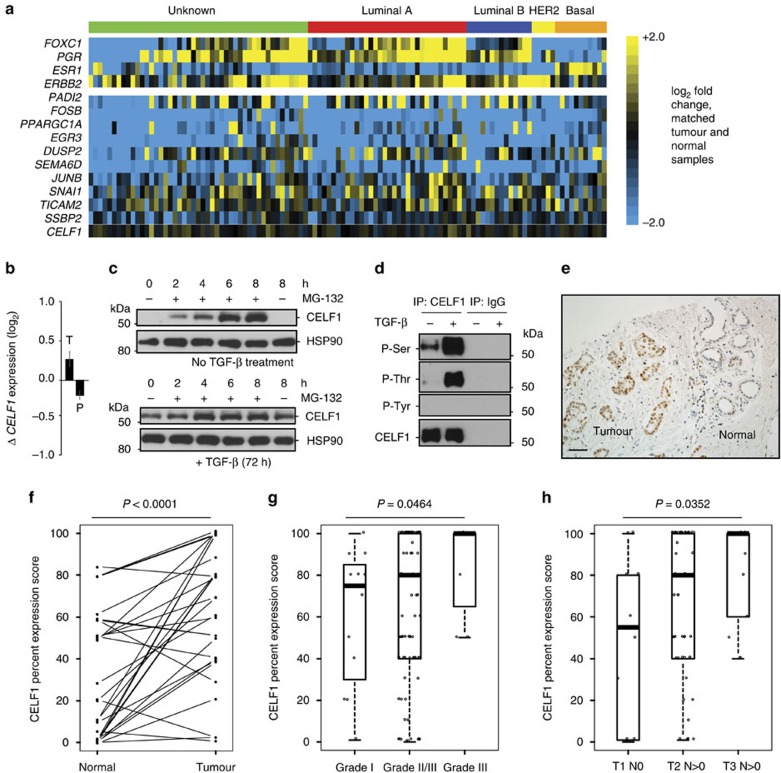
Enhanced CELF1 expression in human breast cancer correlates with increased metastasis.(a) Heat map depicting log2-fold difference in mRNA expression of indicated genes between tumour-normal matched pairs for 111 TCGA patients. Topmost coloured bar indicates PAM50 assignments. Columns are ordered by PAM50 subtype. Top: heat map shows exemplary set of genes correlated with subtype, and bottom: heat map depicts genes translationally regulated by CELF1 during EMT and CELF1. For each heat map, rows are ordered by decreasing variance from top to bottom. Columns are ordered by PAM50 assignment and within PAM50 assignment by increasing mean log2-fold change of genes from left to right. (b) qRT-PCR-based determination of change in steady-state and polyribosomal-bound CELF1 mRNA using total (T) and polyribosomal (P) mRNA obtained from untreated and TGF-β-treated MCF10A cells. Data are represented as mean±s.e.m. All panels are representative of a minimum of three experimental replicates. (c) CELF1 is hyperphosphorylated in mesenchymal MCF10A cells. Immunoprecipitates obtained using anti-CELF1 antibody or mouse IgG from MG-132 treated (8 h) MCF10A±TGF-β (72 h) cells were probed with indicated antibodies. (d) Inhibition of proteasome-mediated degradation results in increased CELF1 protein levels in epithelial MCF10A cells. Cells were incubated with MG-132 for the indicated times and immunoblotted for the indicated proteins. HSP90 serves as a loading control. (e) Representative image of CELF1 protein expression in mammary carcinoma and tumour adjacent normal mammary gland tissue, as analysed by IHC staining. Image was obtained with × 20 objective. Brown staining indicates antigen, while blue staining represents counterstain. Scale bar, 100 μm. (f) Relative CELF1 protein expression as assessed by the per cent score in the 29 matched breast tumour and adjacent normal tissue (P<0.0001; Wilcoxon's signed-rank test). (g) Intracellular CELF1 staining was scored in breast tumour samples from patients with tumour size <20 mm and no lymph node involvement (T1,N0) (n=10), and with lymph node involvement along with tumour size between 20–50 mm (T2,N>0) (n=53) and >50 mm (T3,N>0) (n=13), and the P-value of the trend was determined using the Jonckheere–Terpstra test. Box plots represent the 25th to 75th quartiles with the bold horizontal line representing the median value. (h) Trend between CELF1 expression and tumour grade I (n=12), grade II–III (n=97) and grade III (n=7). The P-value of the trend was determined using the Jonckheere–Terpstra test. Box plots represent the 25th to 75th quartiles with the bold horizontal line representing the median value. See also Supplementary Fig. 6. Full scans of blots are shown in Supplementary Fig. 12.